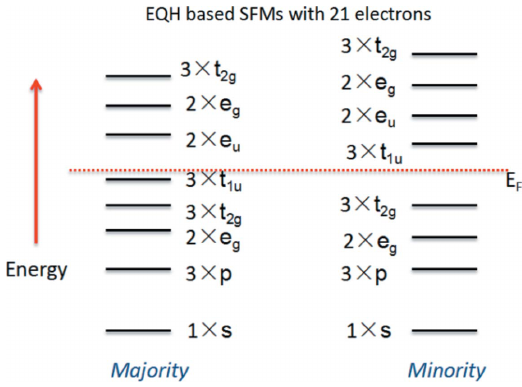
Figure 4 Schematic representation of the band structure for the 21-electron magnetic semiconductors LuCoVSi, LuCoVGe, YCoVSi and YCoVGe in this